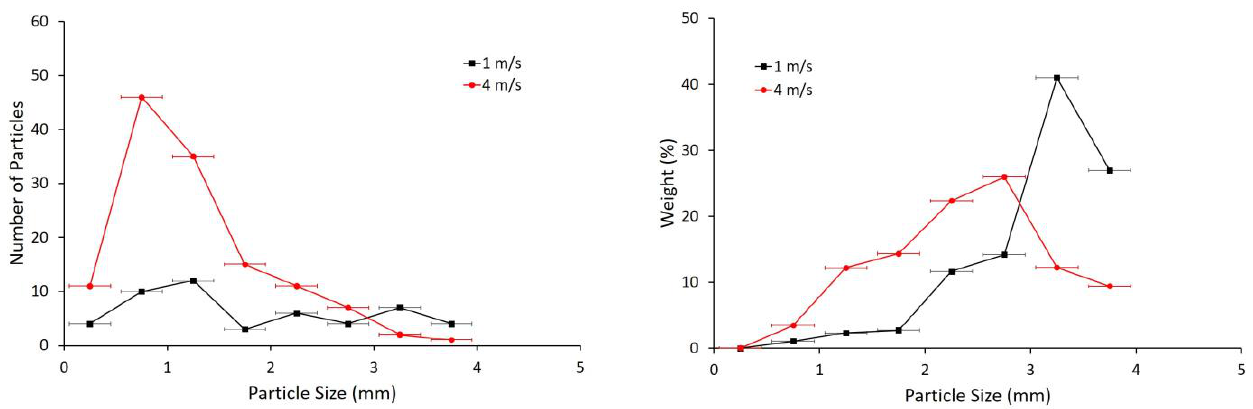
Figure 16. BLS particle size distributions by the number of particles ( left ) and by mass ( right ).